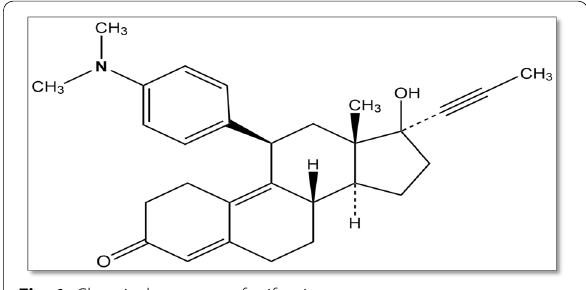
Fig. 1 Chemical structure of